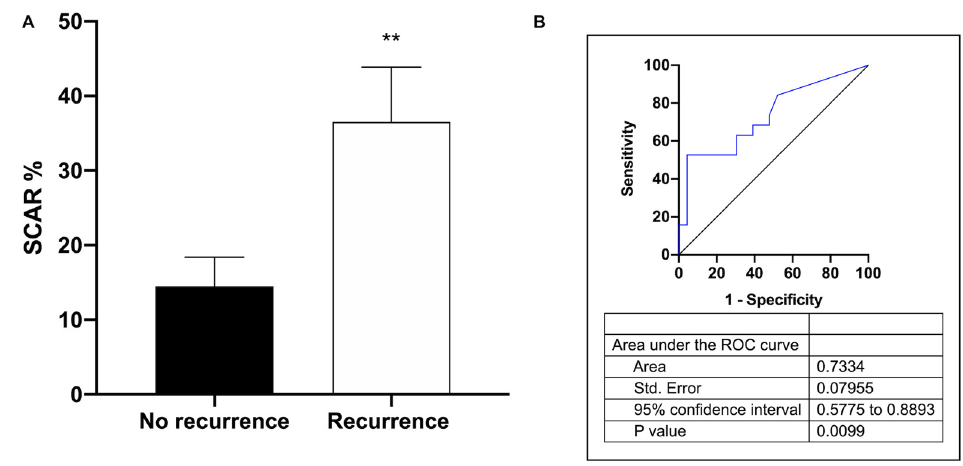
Figure 3. Association between scar percentage and AF recurrence. ( A ) Scar percentage in no re- currence and recurrence patients. ( B ) Receiver-operating characteristic (ROC) curve comparing sensitivity and specificity of recurrence and scar percentage in AF patients. Data are presented as mean ± S.E.M. ** p < 0.01.